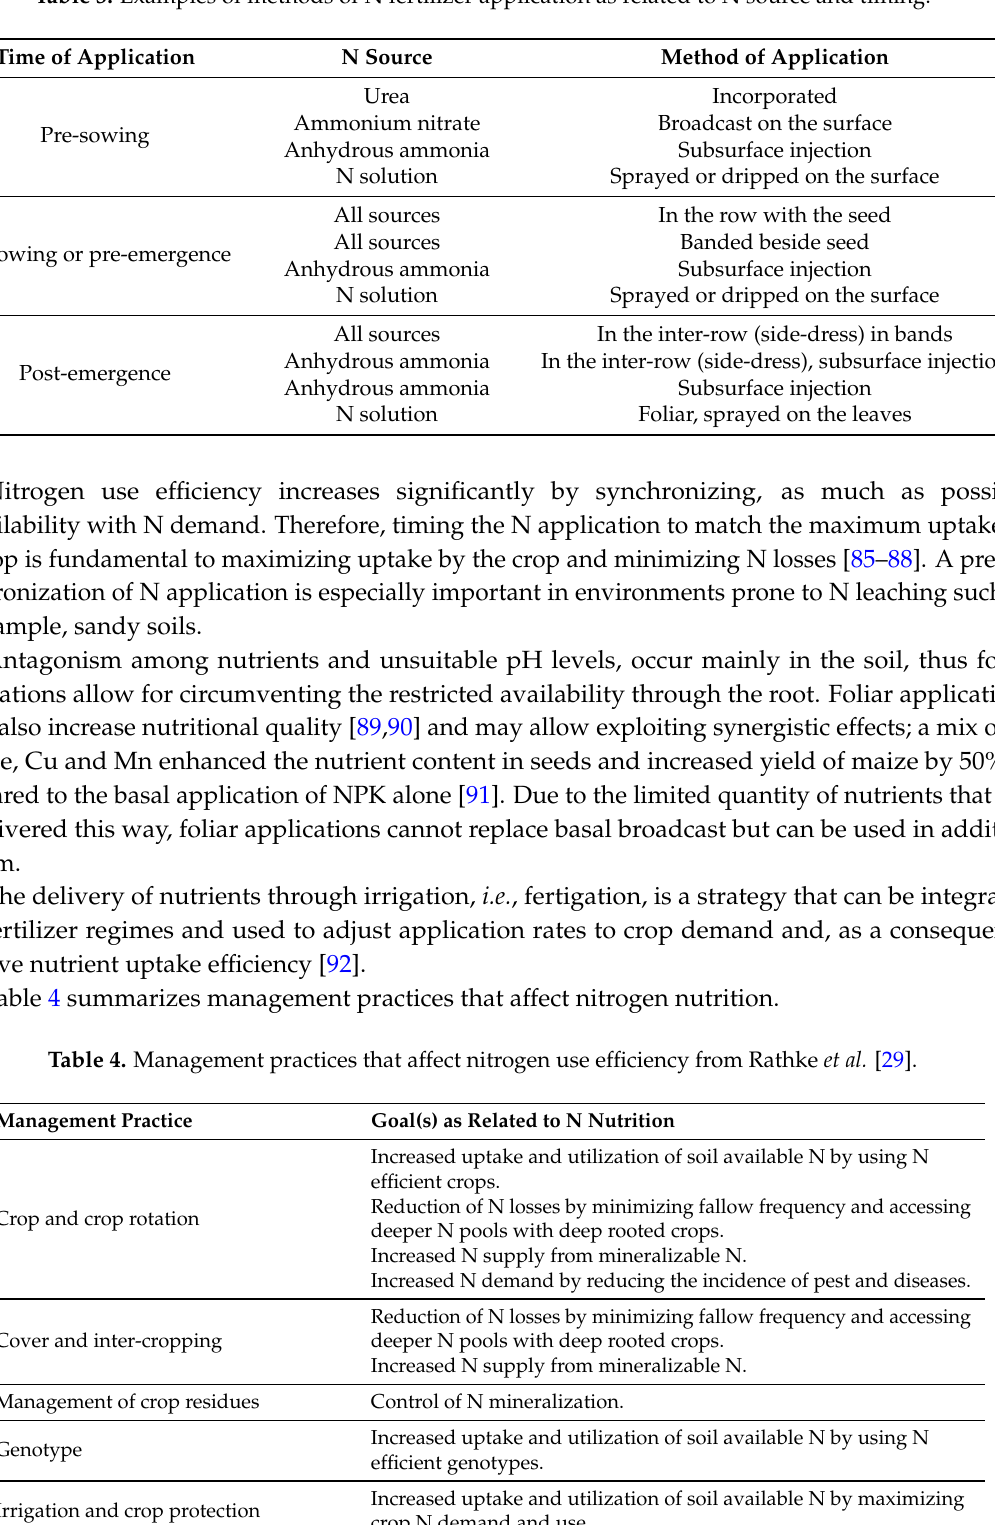
Table 3. Examples of methods of N fertilizer application as related to N source and timing.